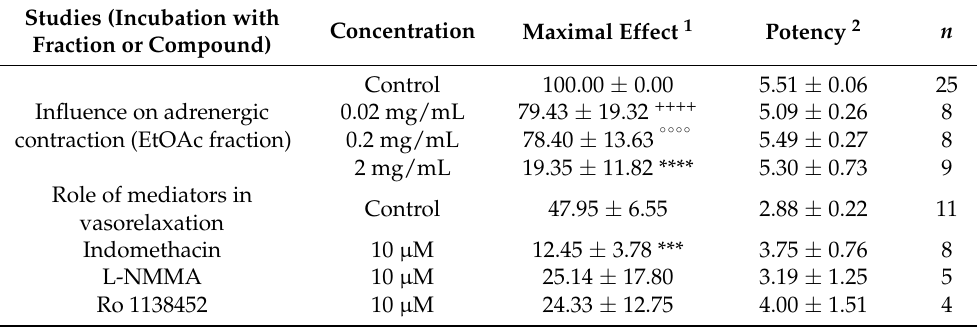
Table 3. Pharmacological parameters from vascular activity studies with the EtOAc fraction of A. eupatoria . Studies (Incubation with Concentration Maximal Effect 1 Potency 2 n Fraction or Compound) Control 100.00 ± 0.00 5.51 ± 0.06 0.02 mg/mL 79.43 ± 19.32 ++++ Influence on adrenergic contraction (EtOAc fraction) 0.2 mg/mL Role of mediators in Control 47.95 ± 6.55 vasorelaxation Indomethacin 10 µ M L-NMMA Results presented as mean ± SEM, and n corresponds to the number of experiments. 1 Maximal effect expressed as maximal contraction (% E max to noradrenaline) for adrenergic contraction studies or maximal relaxation